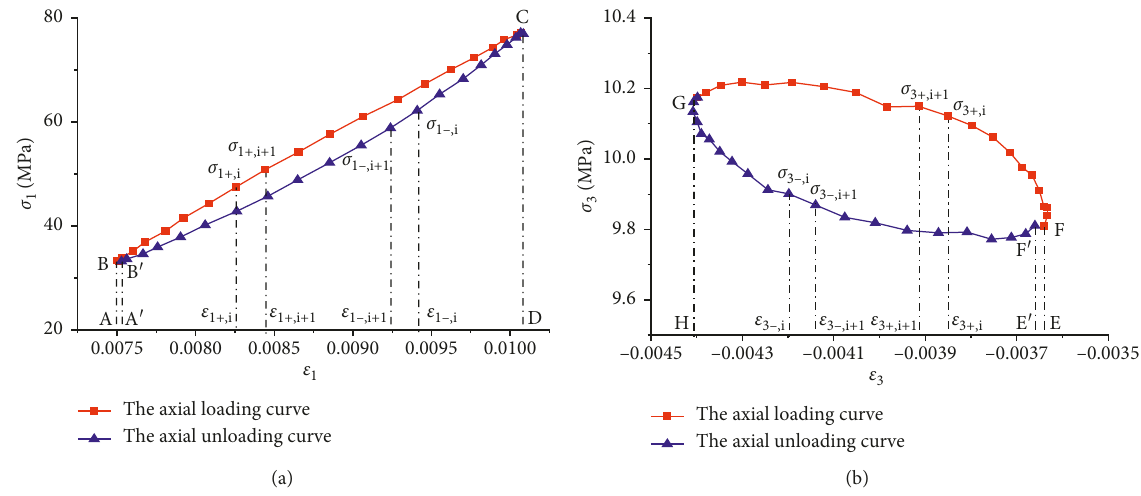
Figure 10: Method for calculating the hysteresis loop area (dissipated energy per unit volume): (a) σ ε 3 hysteresis loop area ( U 3